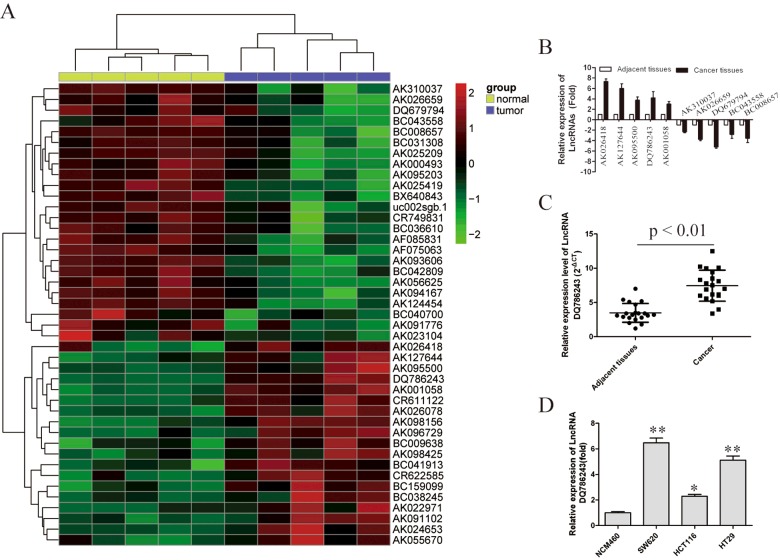
Differential expression of LncRNAs in CRC(A) Heat map analysis of the LncRNAs expression of groups was created using a method of hierarchical clustering by GeneSpring GX, version 7.3. Rows: samples; columns: LncRNAs; colour key indicates LncRNA expression value, red: highest, green: lowest. Microarray data were obtained from GEO, GSE number is GSE3325. (B) We validated the differential expression of six LncRNAs in three paired CRC and non-tumour samples using RT-PCR. (C) RT-PCR analysis of LncRNA DQ786243 expression in 20 paired CRC/non-tumour tissue specimens. (D) mRNA levels of LncRNA DQ786243 was detected by RT-PCR in CRC cell lines SW620, HCT116 and HT29. Data in histograms are means±S.D., *P<0.05, **P<0.01 compared with control cells (t test).